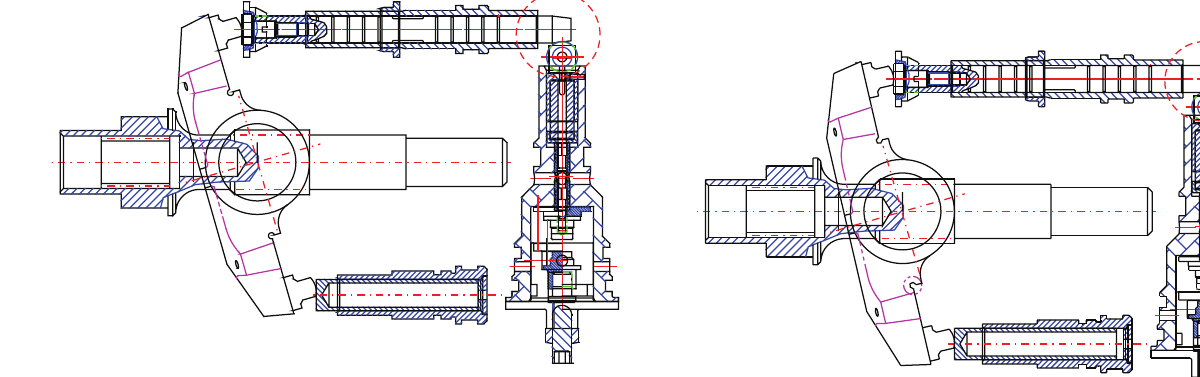
Figure 10: Schematic of VDAPP for the case of constant power.